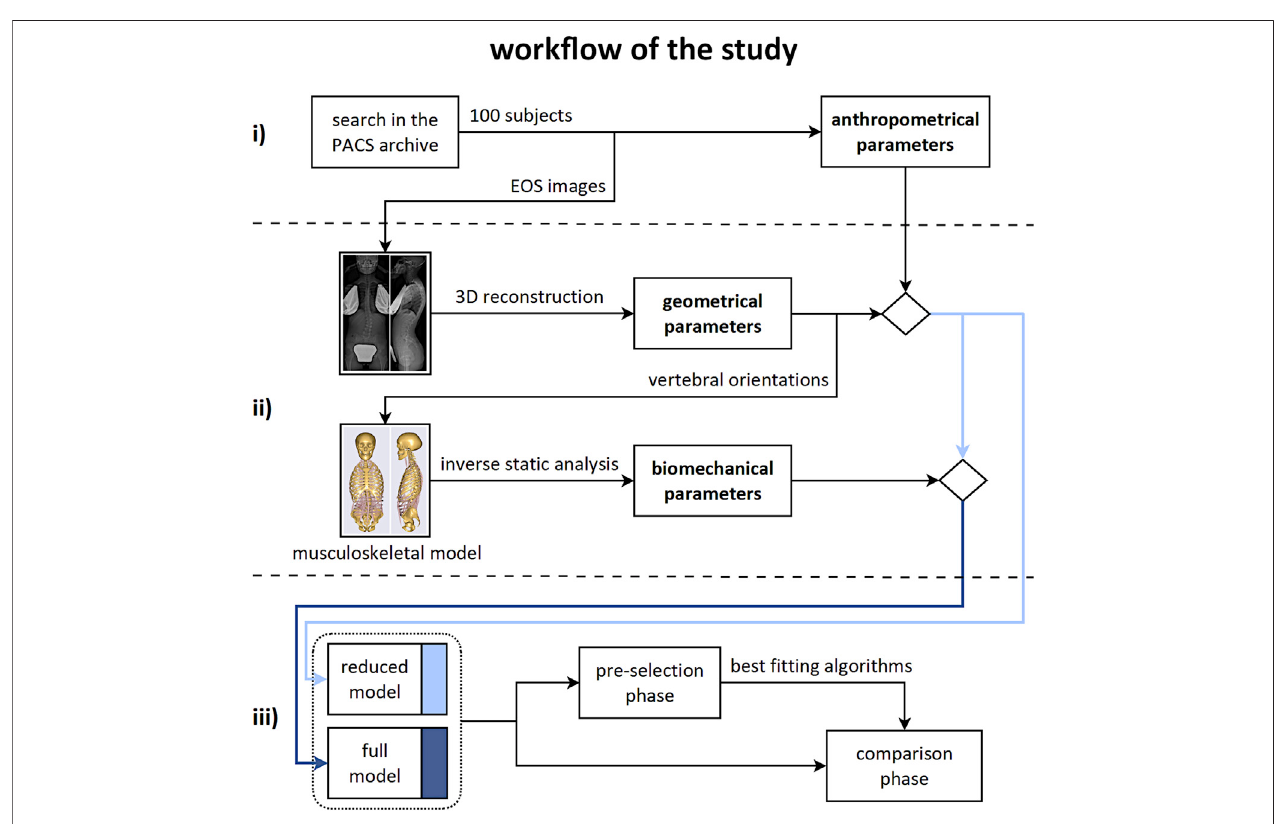
FIGURE 1 | Work fl ow of the study. Consecutive steps from top to bottom row: i) identi fi cation of the subjects dataset and extraction of the anthropometrical parameters; ii) computation of the geometrical and biomechanical parameters; iii) evaluation of the effect of accounting for the biomechanical parameters on the prediction of the scoliosis